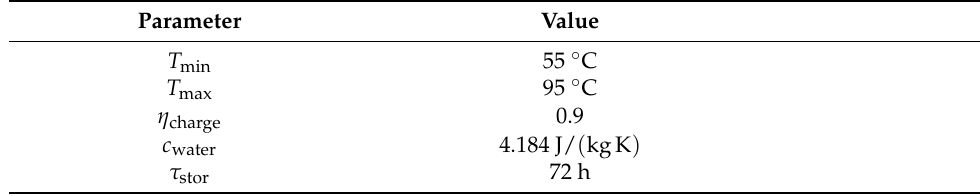
Table 1. Parameters used for the heat storage simulation.